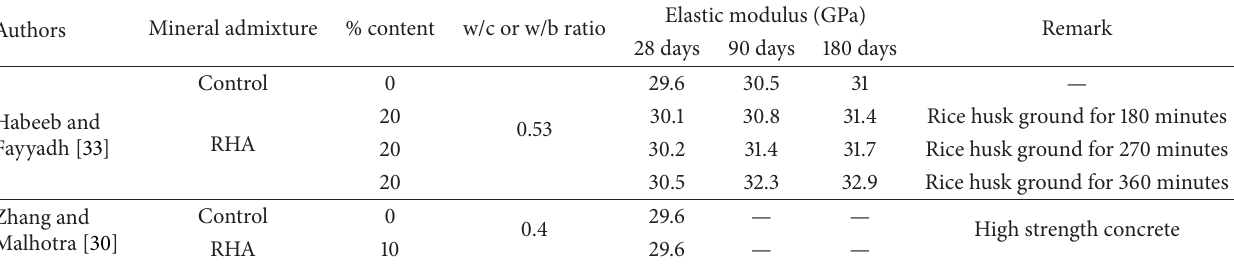
Table 5: Elastic modulus of RHA